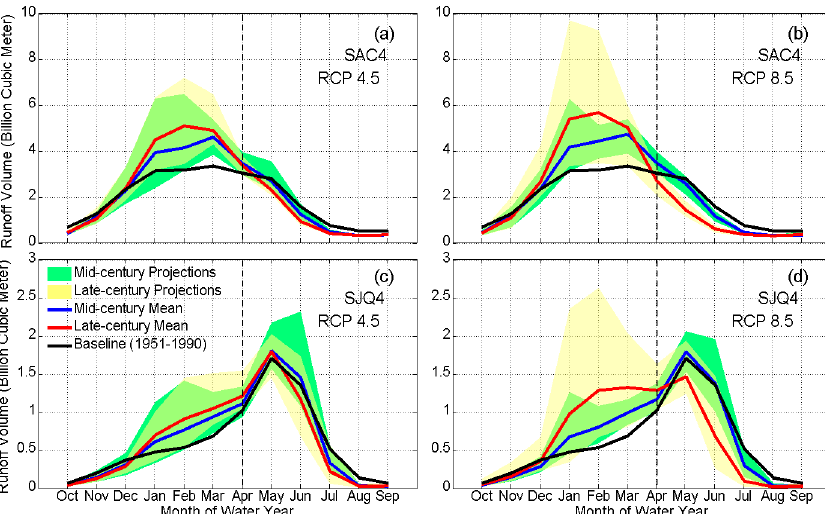
Figure 3. Monthly runoff projections for Sacramento Four Rivers (SAC4; a , b ) as well as San Joaquin Four Rivers (SJQ4; c , d ) under RCP 4.5 and RCP 8.5 projections, respectively. Note that the Y -axis scales for SAC4 and SJQ4 are different. Dash black line indicates the division between flood management season (to the left) and water supply season (to the right).